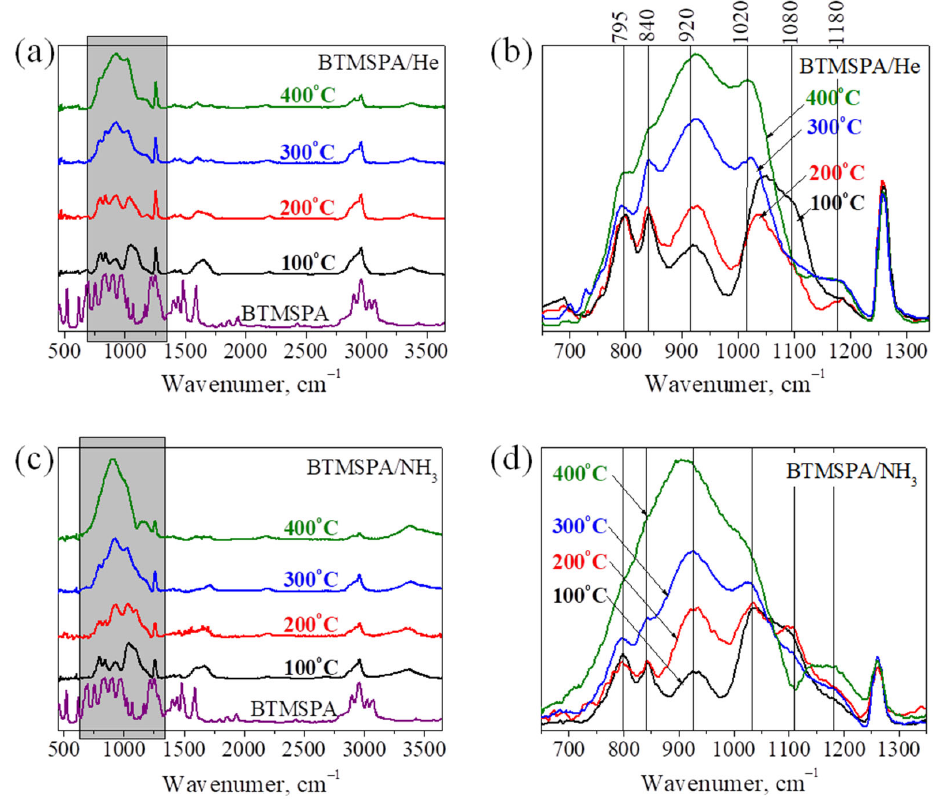
Figure 2. Evolution of wide-range FTIR spectra of SiCN films deposited using BTMSPA/He ( a ) or BTMSPA/NH 3 ( c ) mixtures, and magnification of selected area: ( b ) for BTMSPA/He, ( d ) for BTMSPA/NH 3 gas mixtures.